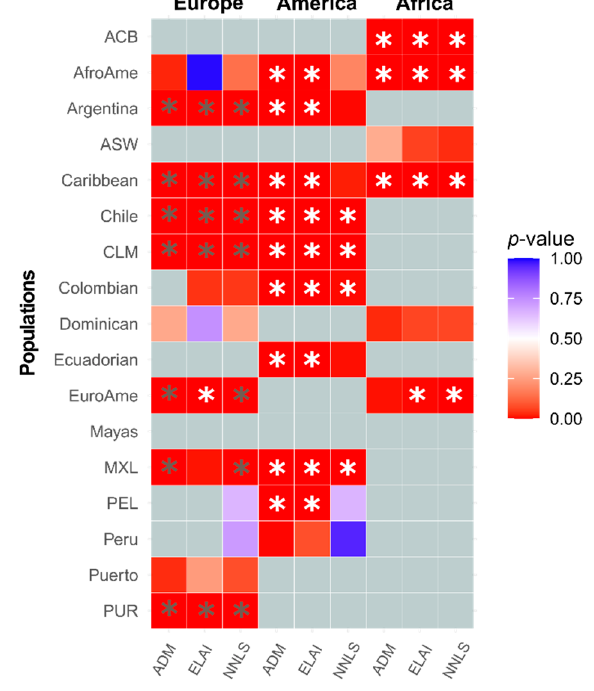
Figure 2. Significance of autosomes vs. X continental proportions in admixed American populations. Squares are coloured based on the adjusted p -value from the Wilcoxon tests reported in Supplementary Table S1D. Grey squares represent those cases in which the population did not pass the filter (average ancestry proportion > 25% and more than 15 individuals). Square colors are based on the p -value as shown in the legend. Grey asterisk indicates that the proportion of the autosomes is significantly higher than those of chromosome X after Bonferroni correction; white asterisk indicates that the proportion of chrX is significantly higher than the autosomal one after Bonferroni correction.